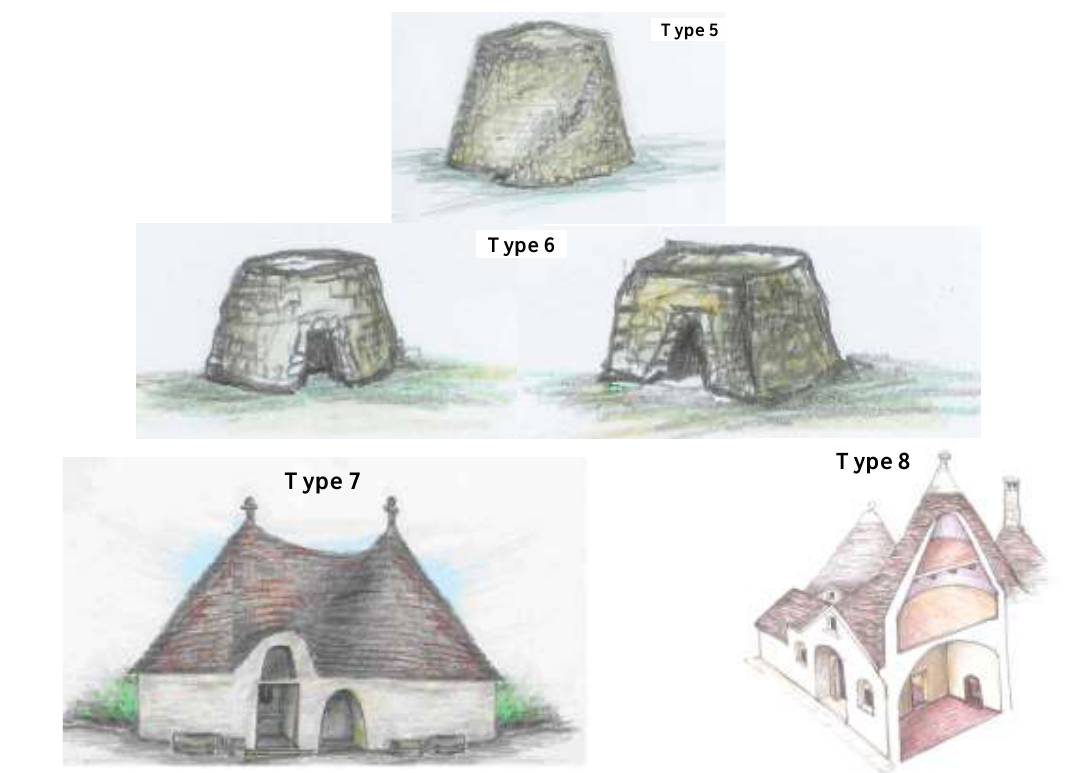
Figure 5. Overview of the trulli typologies.